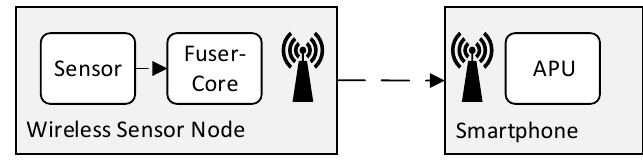
Figure 6. Hardware platform of a smartphone and a wireless sensor